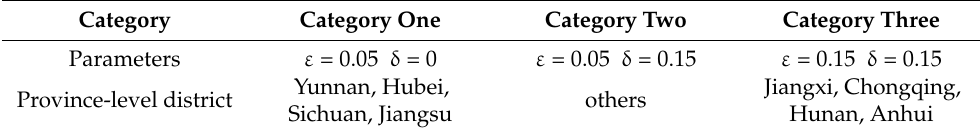
Table 1. The effective flood signal parameter in different province-level